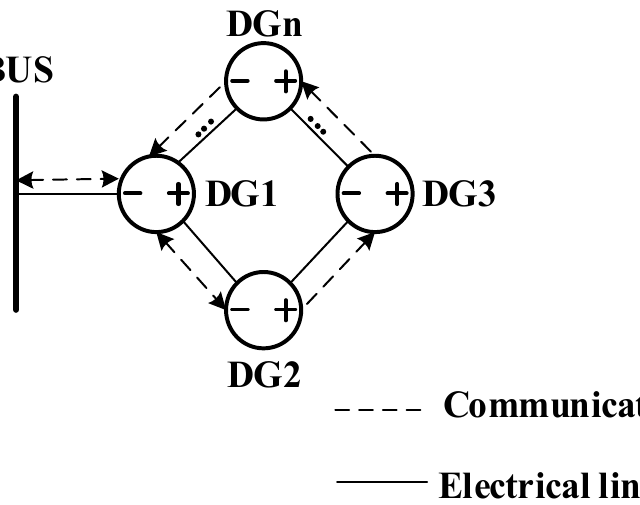
Figure 2. Distributed generation communication structure.